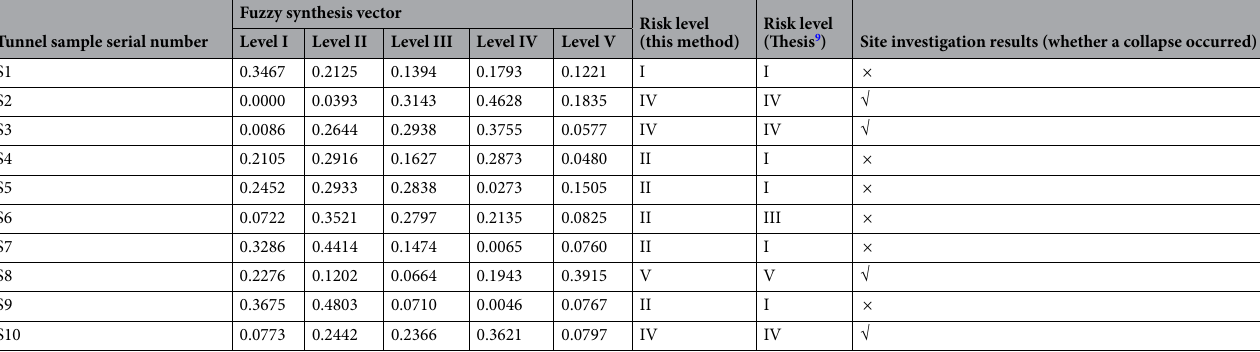
Table 12. Comparison of evaluation results with field